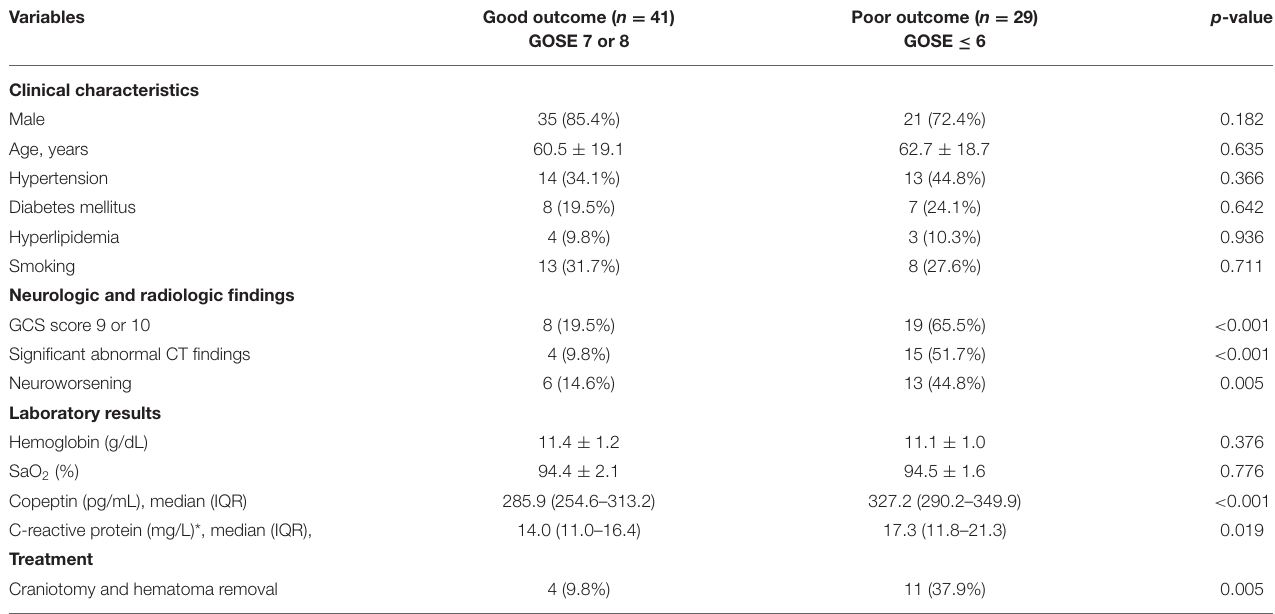
TABLE 1 | Differences in clinical characteristics, neurologic and radiological findings, laboratory results, and treatment in patients with moderate traumatic brain injury (TBI) according to neurologic outcomes. Variables